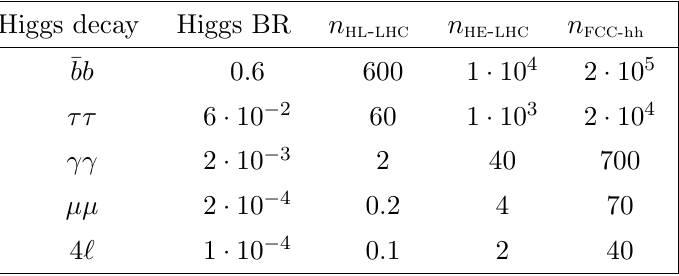
Table 1 . Number of Wh ! ‘(cid:23) XX events predicted by the SM at LO for di(cid:11)erent Higgs decay channels and with a cut p h > 550 GeV. The results correspond to 3 ab (cid:0) 1 , j (cid:17) j < 2 : 5 for the HL-LHC, T 15 ab (cid:0) 1 , j (cid:17) j < 6 for the HE-LHC and 30 ab (cid:0) 1 , j (cid:17) j < 6 for the